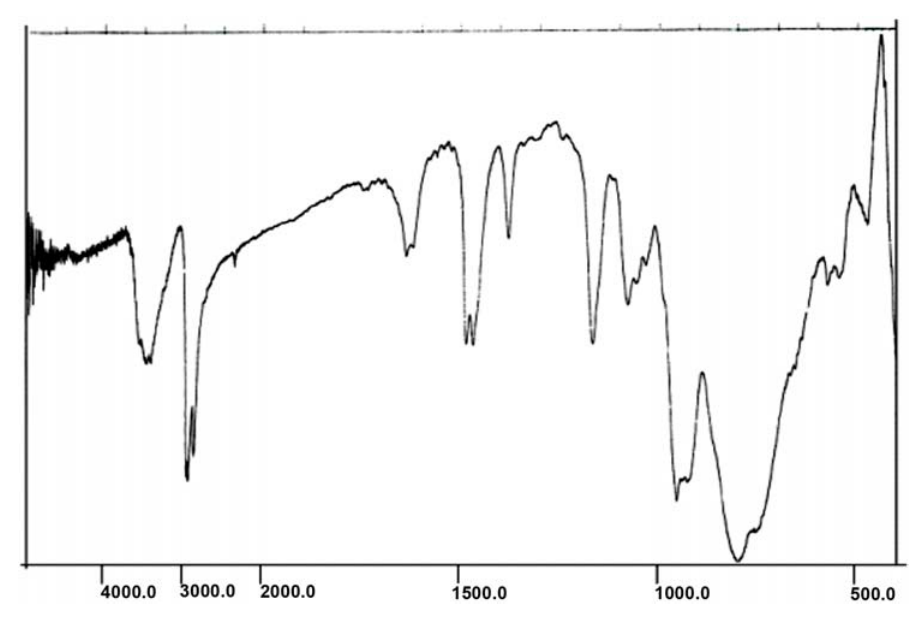
Figure 1. IR spectrum of compound